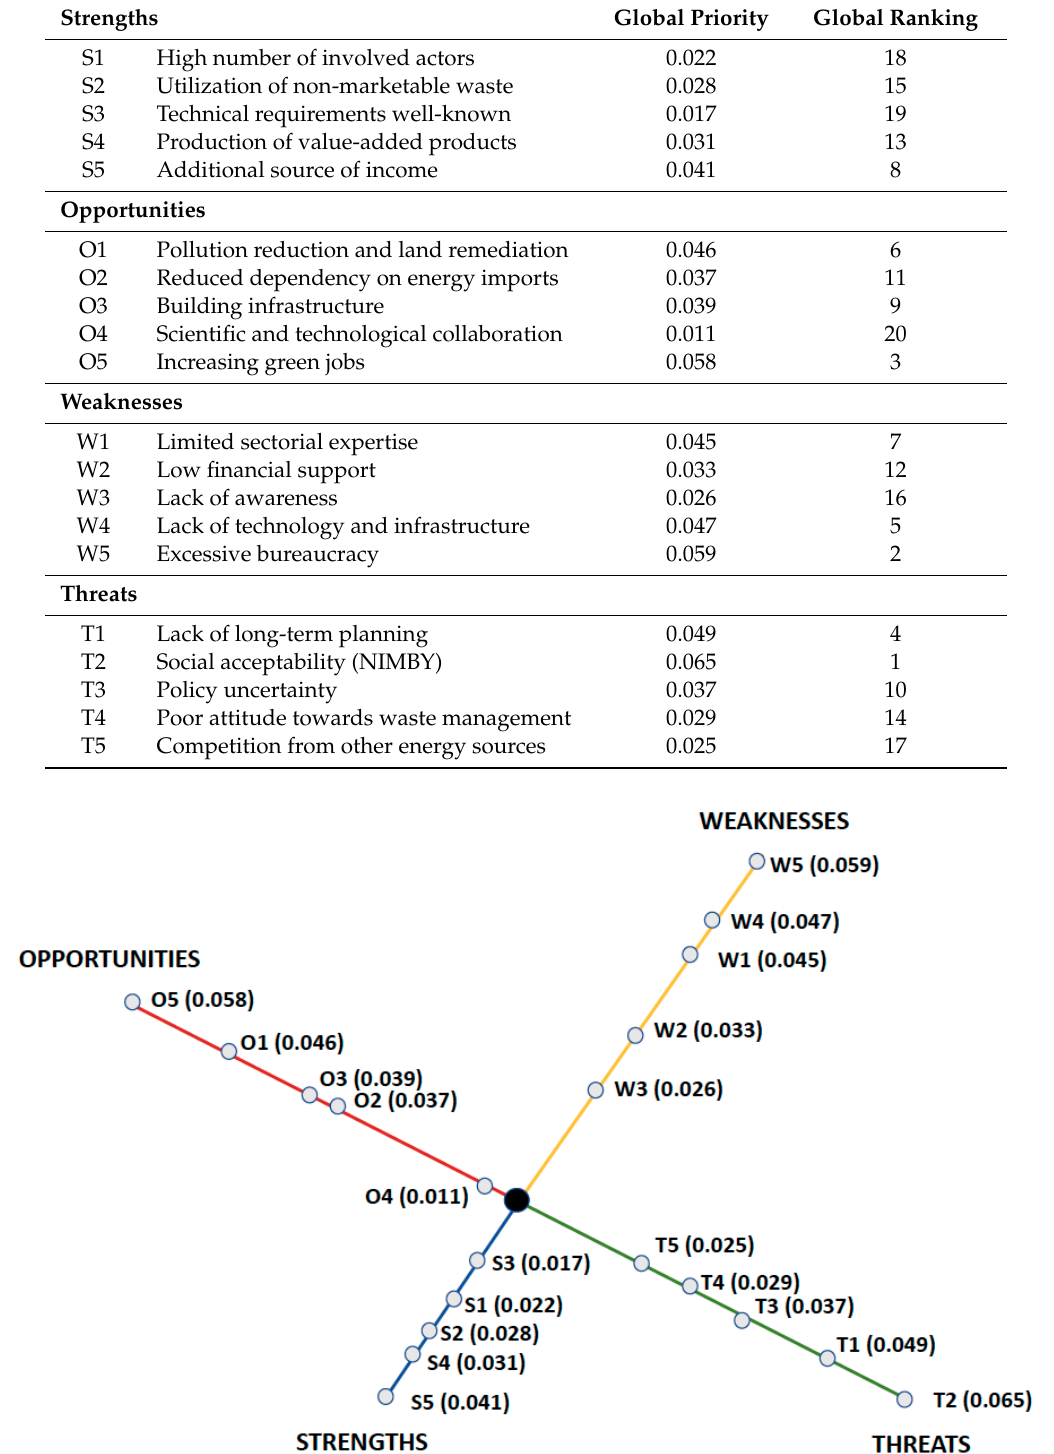
Figure 5. Graphical representation of SWOT factors and their corresponding global priorities. Source: